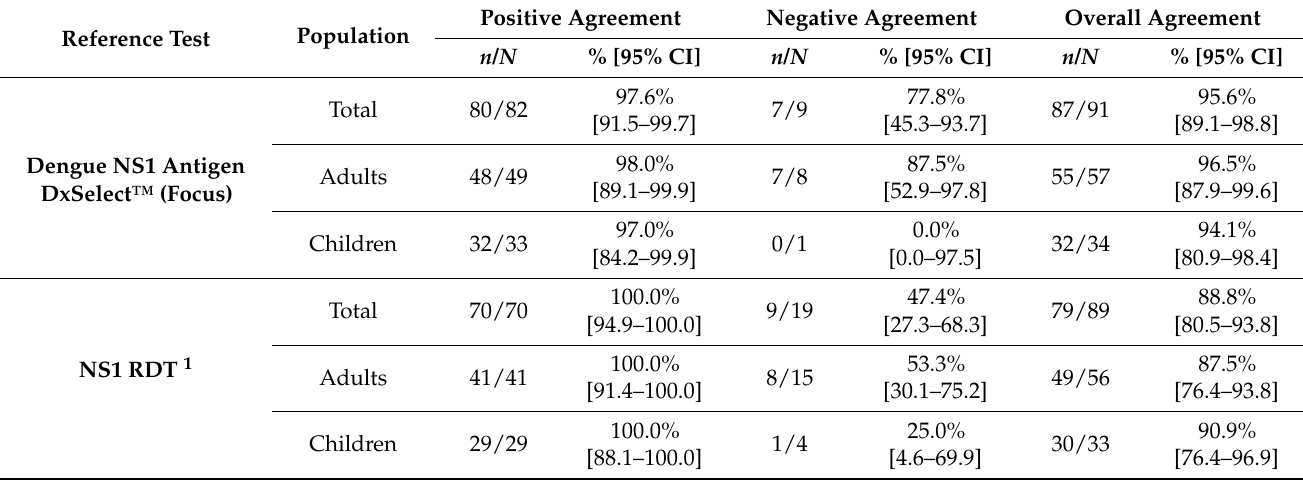
Table 3. Concordance of VIDAS ® Dengue NS1 Ag and competitor